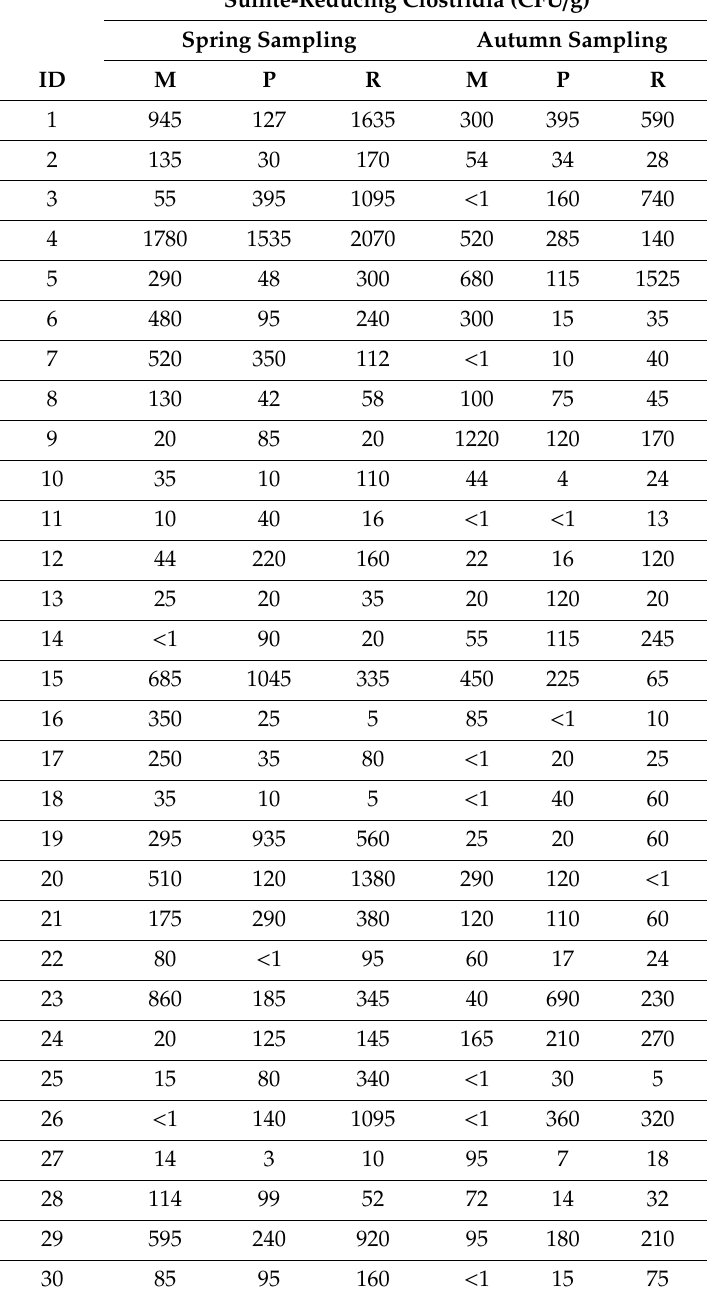
Table 6. Sulfite-reducing clostridia. Microbial counts are reported. Similarly to the partition done for TVCs, 53.9% of clostridia counts are in the < 100 CFU / g class (white background), 40.6% in the P—peloid, R—regenerating used mud. Sulfite-Reducing Clostridia (CFU / g) Spring